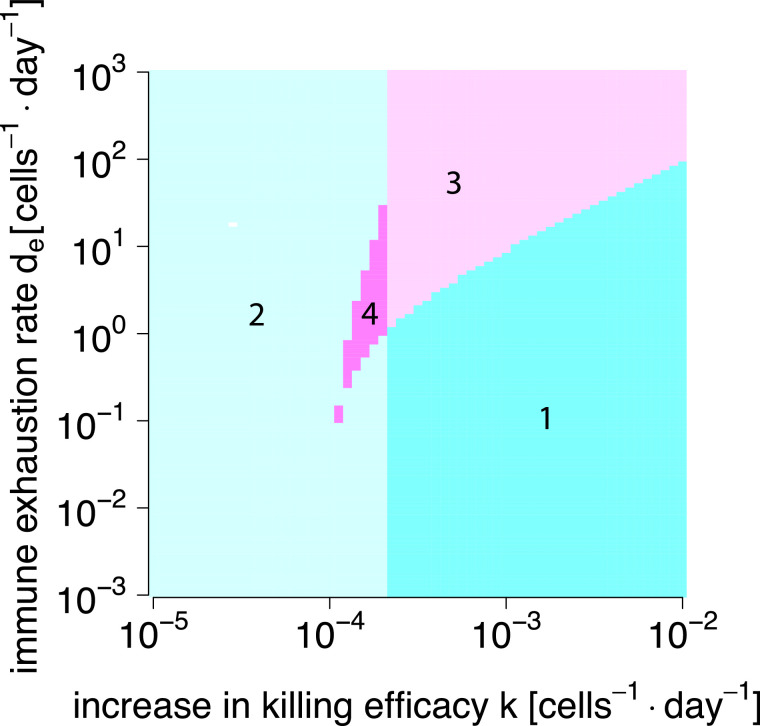
Number of possible non-negative steady states ofTof the model(10), (11). Shown is the region of parameter space spanned by killing efficacy k and effector cell exhaustion de divided into regions of different non-negative fixed points of the model (10), (11). The number of roots were identified numerically by means of the rootSolve package in R (Soetaert, Herman, 2008, Soetaert, Soetaert, Petzoldt, Setzer, 2010). Numbers indicate the number of non-negative fixed points in each parameter region. The region that supports multistability is colored in violet. The region that admits bistability (3 fixed points) is adjacent to the multistability region. The other used paramaters are as in Table 2.